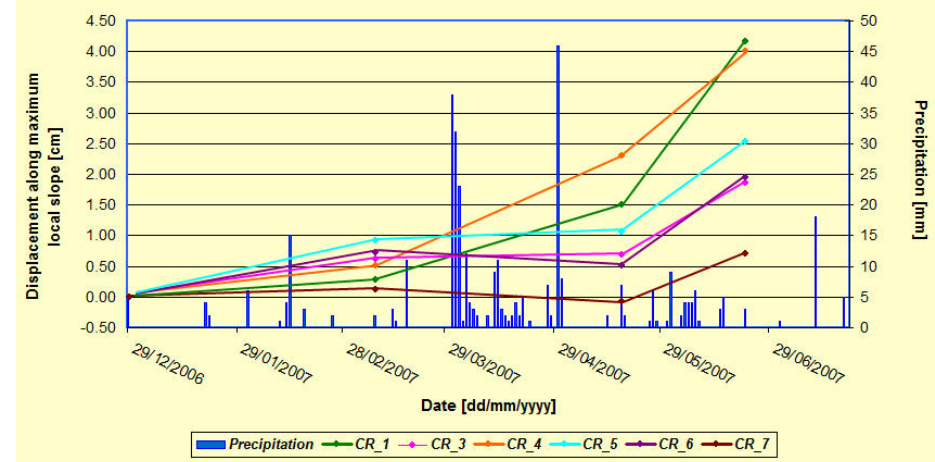
Fig. 6. Time series showing the temporal evolution of the Corner Reflectors (CRs) displacements projected in the direction of the maximum Figure 6. Time series showing the temporal evolution of the Corner Reflectors (CRs) 2 local slope angle and precipitations recorded during the analysed displacements projected in the direction of the maximum local slope angle and precipitations 3 recorded during the analysed period. 4